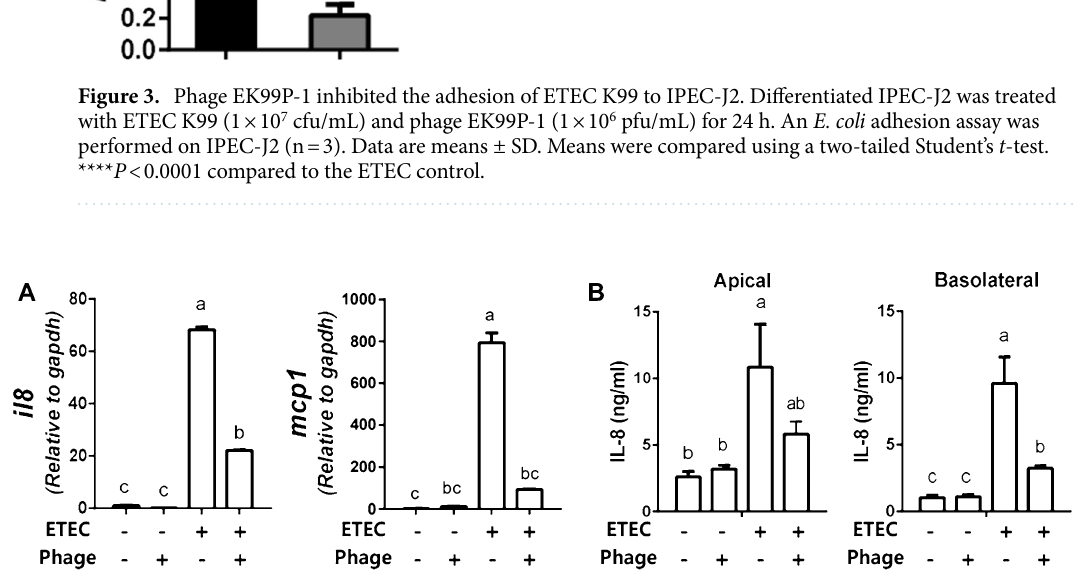
Figure 4. Phage EK99P-1 inhibits inflammatory responses in IPEC-J2 infected with ETEC K99. Differentiated IPEC-J2 were treated with ETEC K99 (1 × 10 7 cfu/mL) and phage EK99P-1 (1 × 10 6 pfu/mL) for 24 h. ( A ) The expression of cytokine and chemokine mRNA in differentiated IPEC-J2 was measured by RT-PCR after 24 h of treatment (n = 3). ( B ) IL-8 secretion was measured at supernatant in apical and basolateral side of transwell plate by an enzyme-linked immunosorbent assay (ELISA; n = 3). Data are means ± SD. Means were compared using one-way ANOVA, followed by Friedman’s test and Tukey’s multiple comparison test. Different letters in each group indicate significant differences at P <